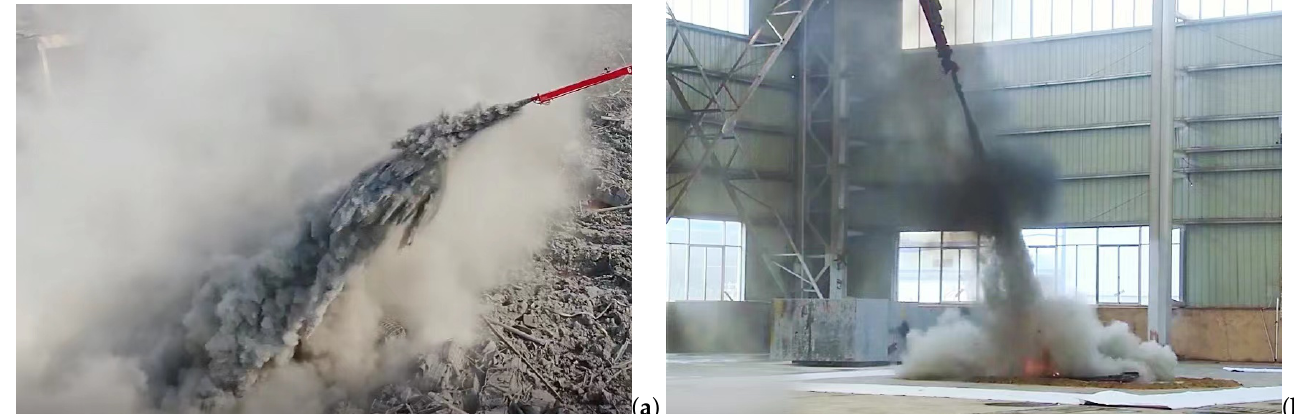
Figure 1. The powder jet fire suppression system: ( a ) full scale fires and ( b ) laboratory scale